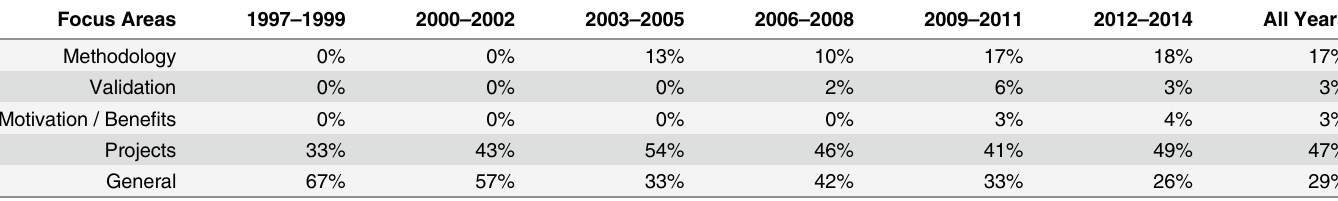
Table 1. The percentage of published articles divided into focus areas from 1997 to 2014. Focus